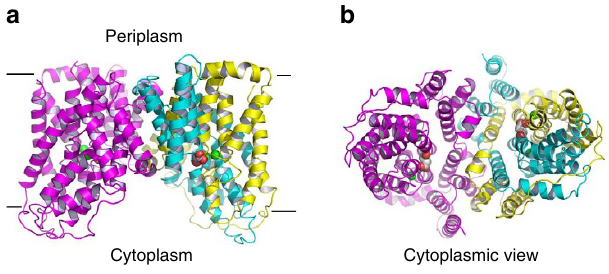
Figure 1 | Structure of the succinate-bound VcINDY. ( a ) Structure of dimeric VcINDYas viewed from the membrane bilayer. VcINDY is shown in ribbon rendition, the N (18–231) and C (232–462) domains in one protomer are coloured cyan and yellow, respectively, whereas the other protomer is coloured magenta. Na þ ions (green) and succinate are drawn as spheres. ( b ) The cytoplasmic view of the VcINDYstructure, highlighting the solvent- accessible succinate and buried Na þ ions.